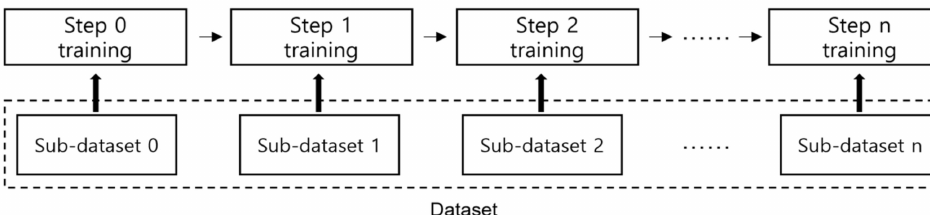
Figure 1. Conceptual diagram of continual